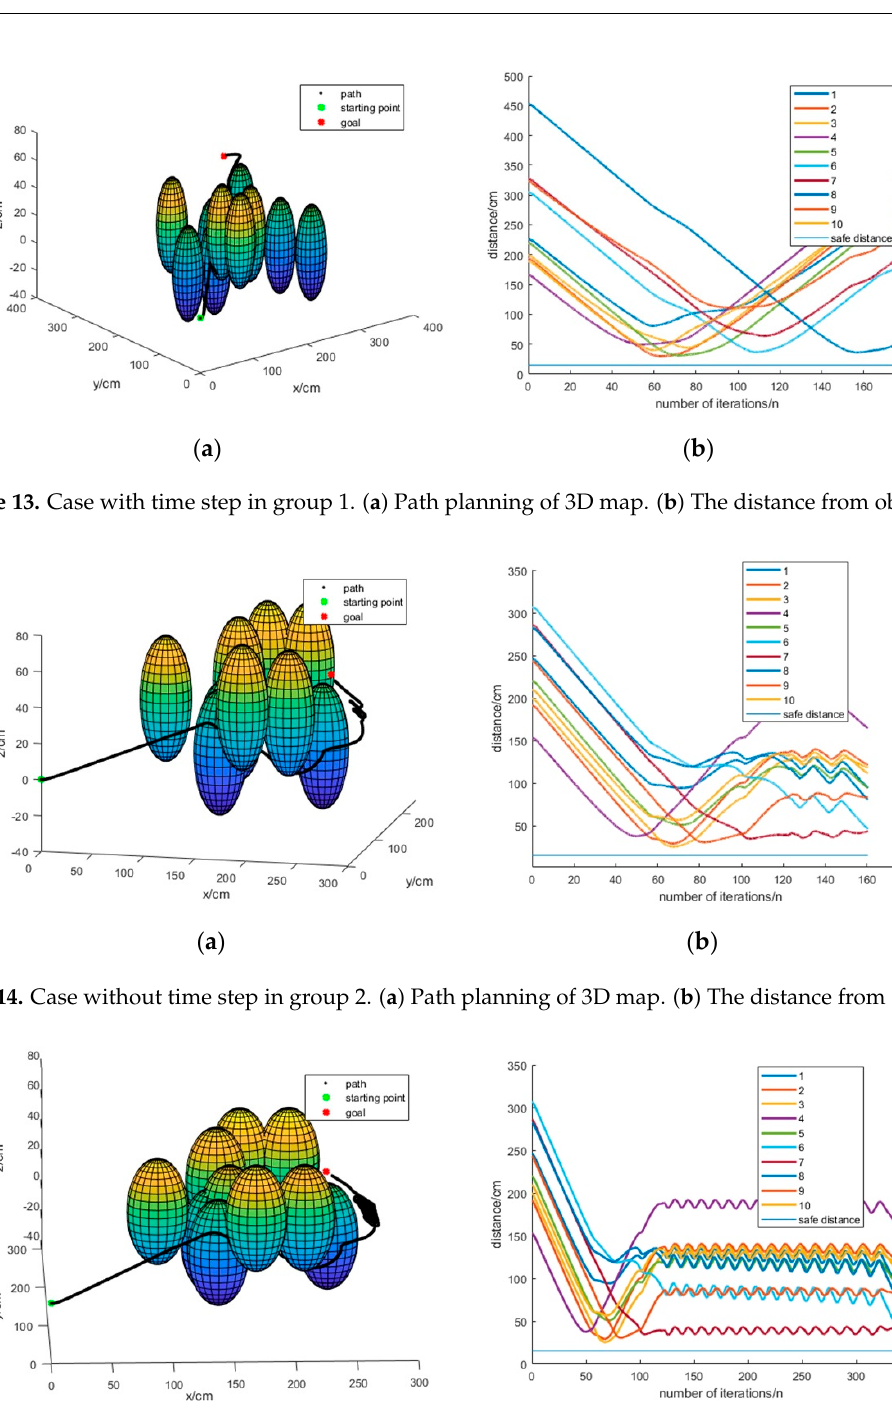
Figure 12. Case without time step in group 1. ( a ) Path planning of 3D map. ( b ) The distance from obstacles.